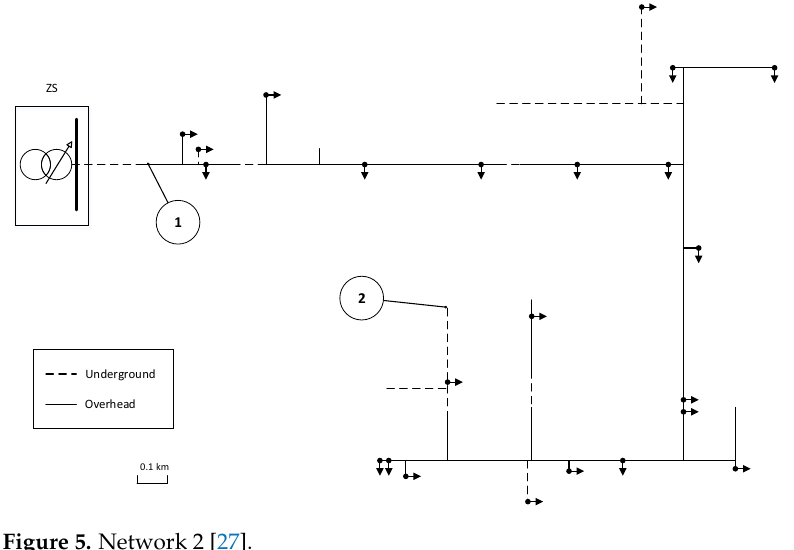
Figure 5. Network 2